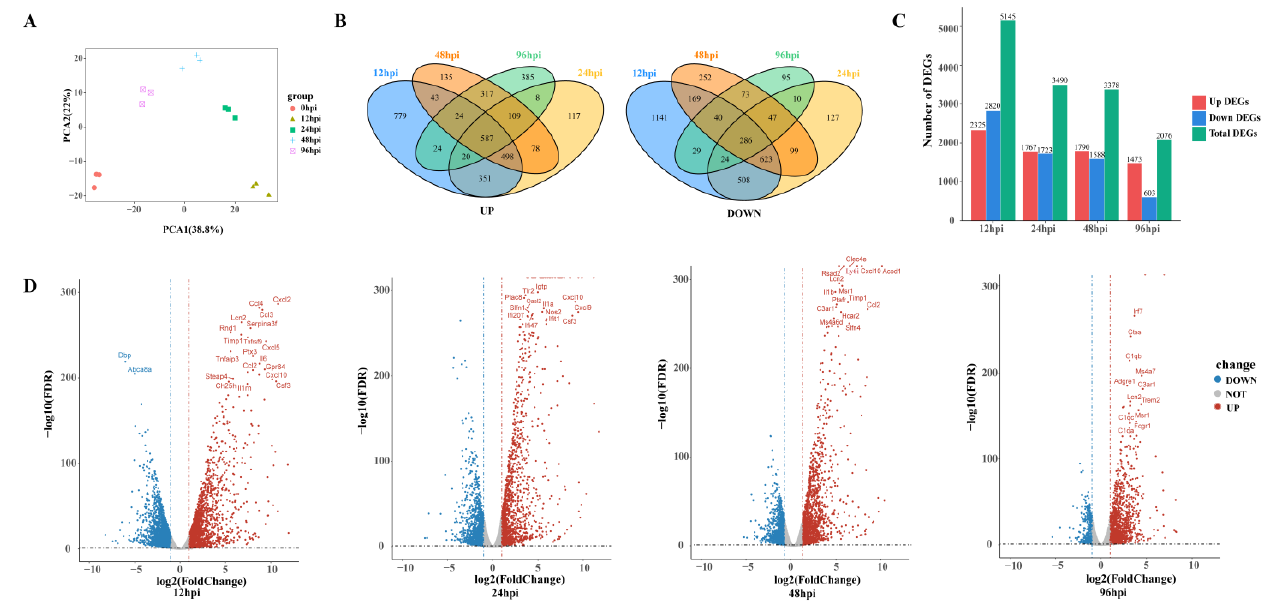
Figure 2. An overview of transcriptome analysis. ( A ) Principal component analysis (PCA) results of lung tissue RNA-seq data after SA infection. The same color represents replicates of the same stage. ( B ) Venn diagram comparing the upregulation and downregulation differentially expressed genes (DEGs). ( C ) Histograms show different genes at different time points. ( D ) Volcano plot of RNA-seq transcriptome data displaying the pattern of gene expression. Significant DEGs (FDR p ≤ 0.05) are highlighted in red (upregulated) or blue (downregulated). Curatorial genes with specific biological functions are labeled.